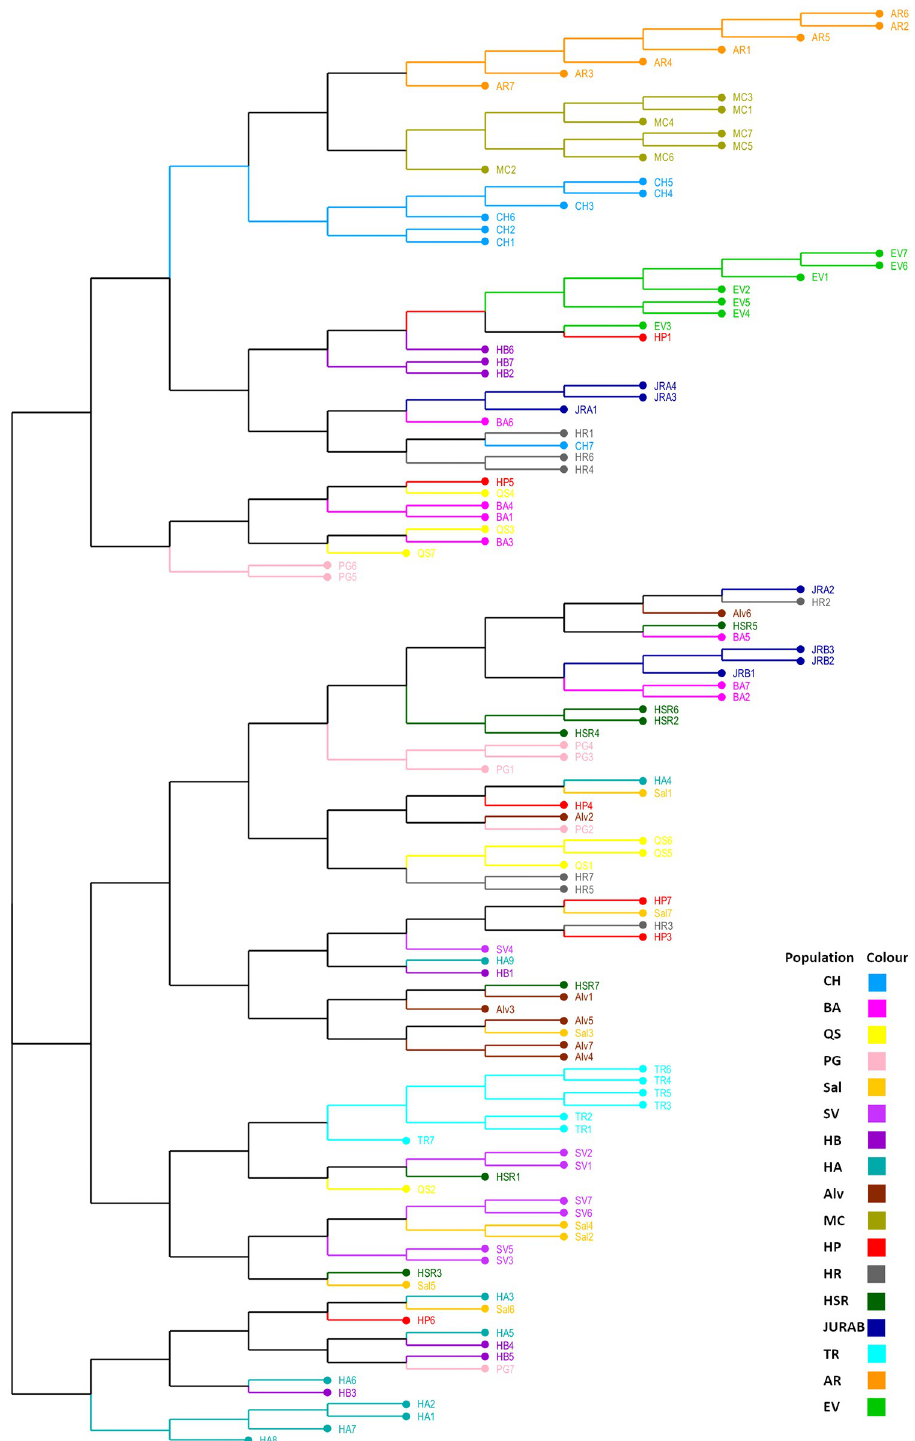
Fig 4. NJ phylogenetic tree showing affiliations of the Cynara cardunculus populations based on genetic dissimilarity of SSR microsatellite analyses. Geographic origin of populations is identified by a colour (see Table 1 for abbreviations of geographic